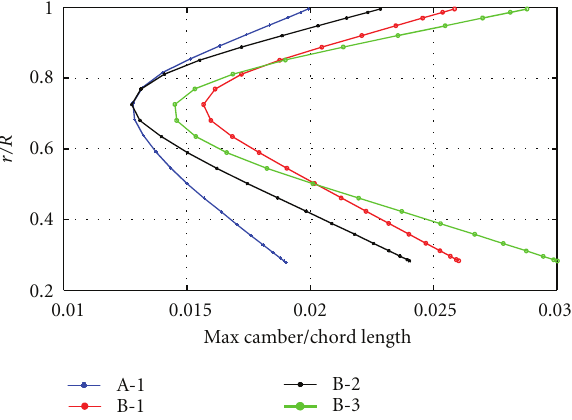
Figure 26: Nondimensional circulation, aft